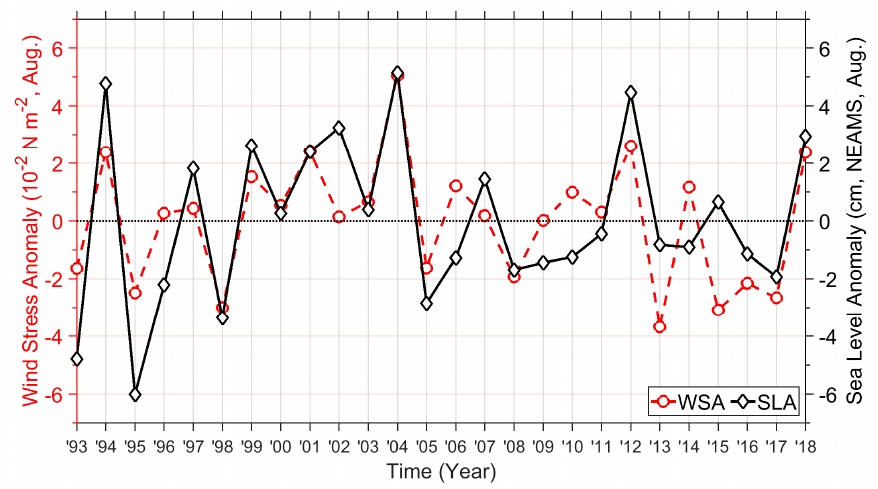
Figure 8. Time-series of area averaged northwestward wind stress anomaly in the WA (red dashed line, left y-axis), and August NEAMS sea-level anomaly observed from satellite altimetry (black line, right y-axis) from 1993 to 2018. The correlation coe ffi cient is 0.73 with p -value <